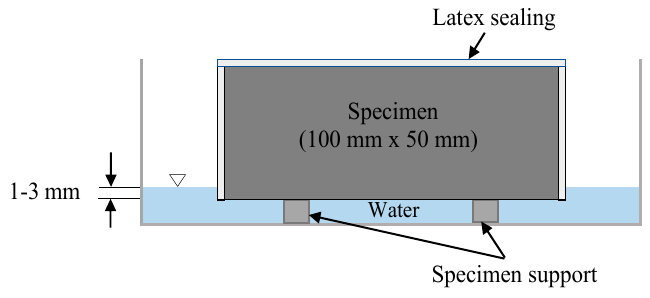
Figure 4. Schematic of sorptivity test setup.